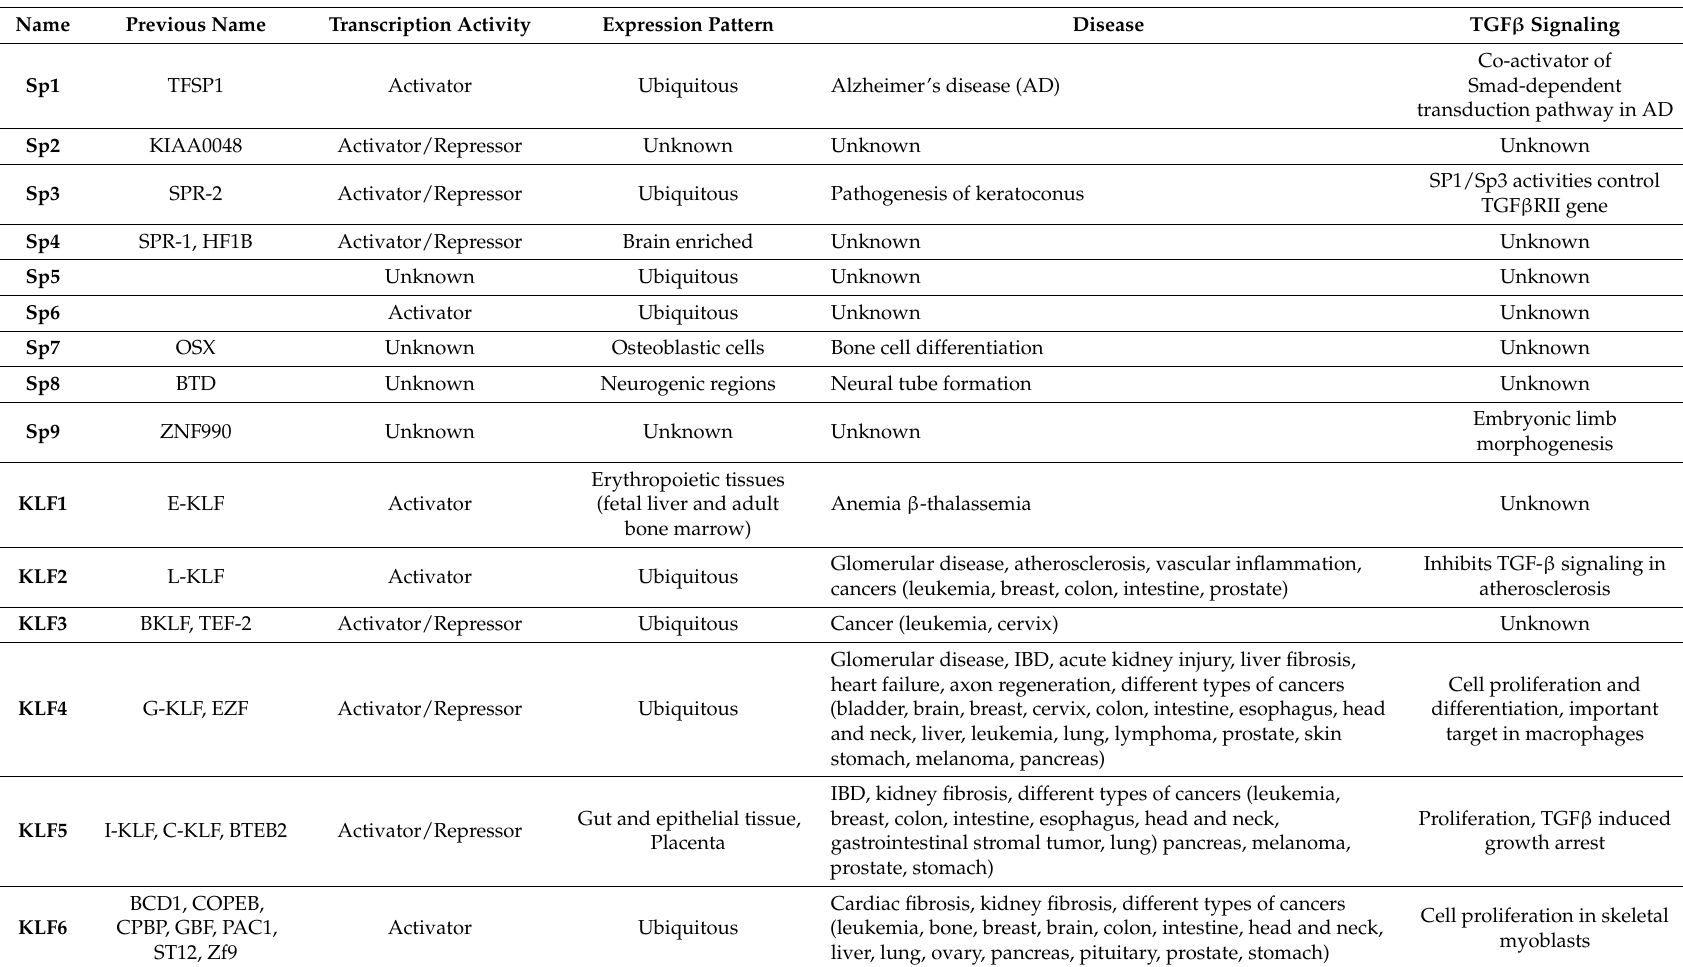
Table 1. SP (specificity proteins)/KLF (Krüppel-like Factors) family of transcription factors and their